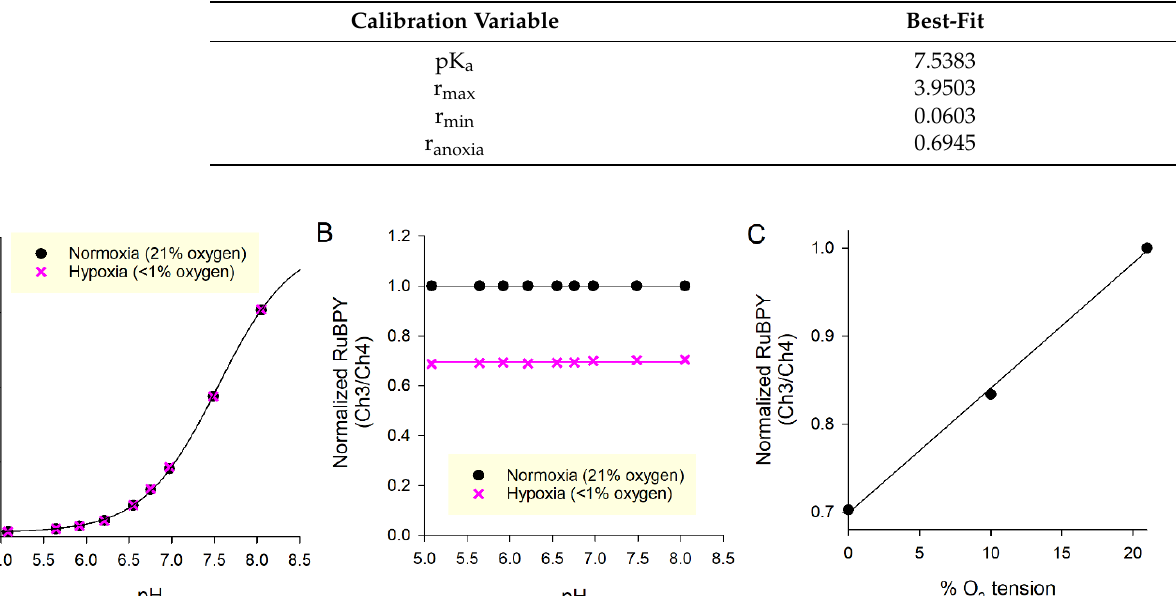
Figure 2. ( A ) The calibration curve for the HPTS ratio (Ch2/Ch1) in normoxic and hypoxic conditions. Best-fit to Equation (1) with constants listed in Table 1. ( B ) Hypoxia-sensitive ratio of isosbestic HPTS to RuBPY (as Ch3/Ch4). Hypoxia (<1% O 2 ) reduces the Ch3/Ch4 ratio but is pH-insensitive. ( C ) Three-point calibration for 0.1%, 10%, and 21% O 2 .